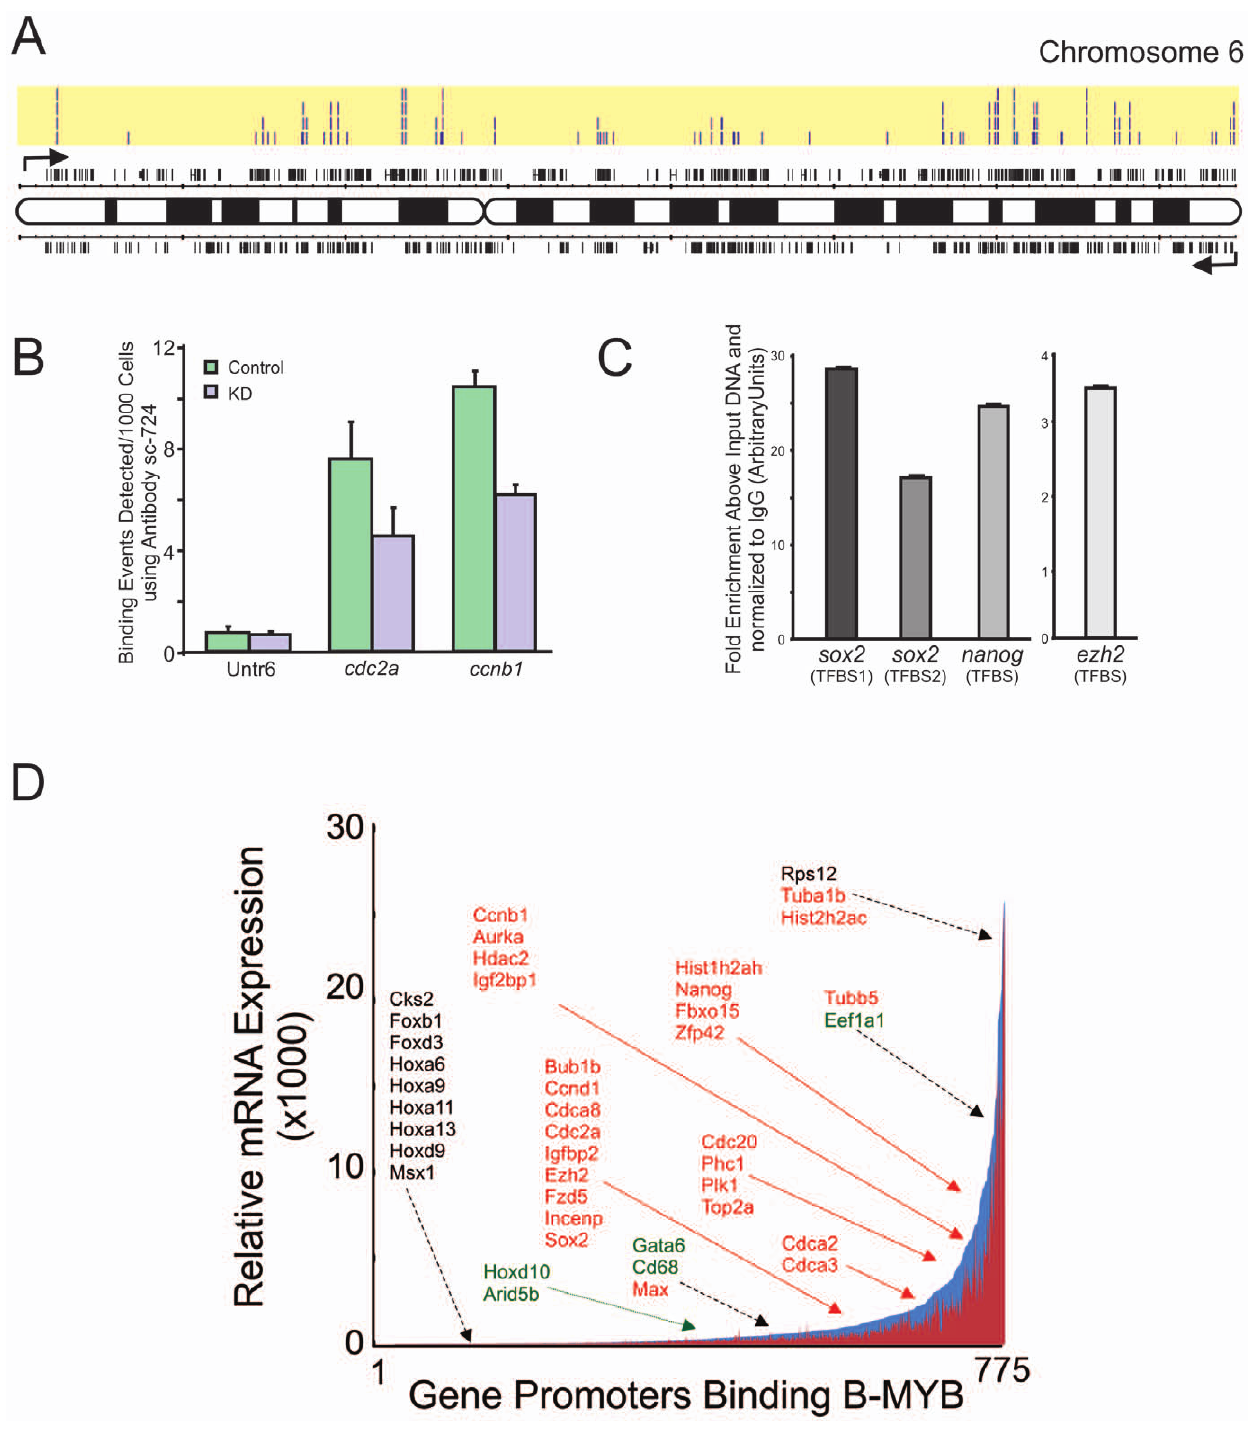
Figure 6. Identification of B-MYB binding sites on gene promoters and corresponding gene expression profiles. A) ChIP-chip analysis showing the locations and number of B-MYB binding sites (highlighted in yellow shading, n=4 biological replicas) and corresponding genes on Chromosome 6 (for details, see Table S6). Binding was determined from promoter regions corresponding to 8 kb upstream and 2 kb downstream of the 25,500 transcription start sites of the whole mouse genome. B) To determine antibody specificity, ChIP assays of known B-MYB target genes were performed in ESCs after B-MYB knockdown. Relative to controls, the number of binding events on known target genes cdc2a and ccnb1 was significantly reduced in B-MYB deficient cells (KD), indicating that the antibody had good specificity for B-MYB. Untr6 – Untranscribed control DNA sequence. See Methods for experimental details. C) Independent ChIP assays using IgG precipitated chromatin as a control confirming binding of B- MYB to the promoter regions identified by ChIP-chip for sox2 (two sites), nanog and ezh2 . D) Plot of B-MYB target genes (Table S6) with corresponding microarray expression data taken from Table S1. This plot indicates that B-MYB target genes have expression levels ranging from just detectable to elevated.